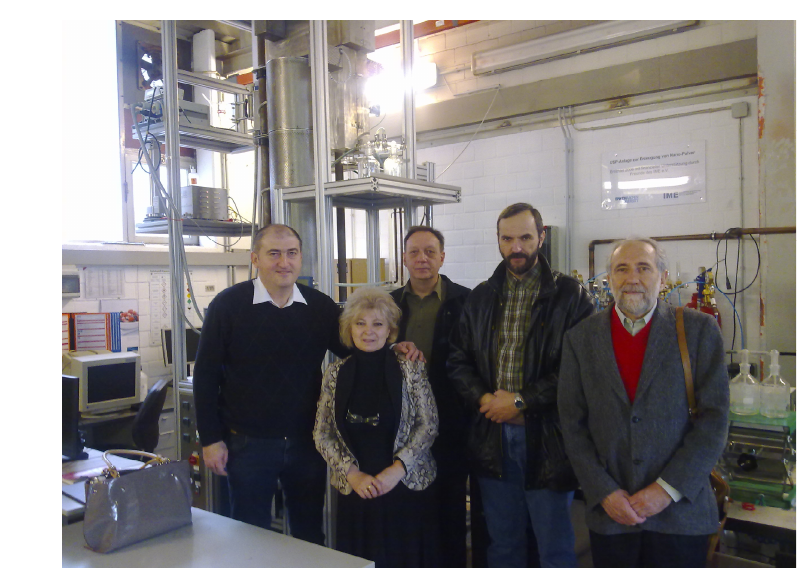
Figure 3 – Srecko Stopic (RWTH Aachen University); Olivera Milosevic (Institute of Technical Sciences of SASA, Belgrade); Sava Maksimovic, Miroslav Ravlic, Nebojsa Pejcinovic (Prizma, Kragujevac) in the laboratory of the IME Process Metallurgy and Metal Recycling of the RWTH Aachen University, Germany (March 21, 2013) Slika 3 – Sre ć ko Stopi ć (Univerzitet RWTH Ahen); Olivera Miloševi ć (Institut